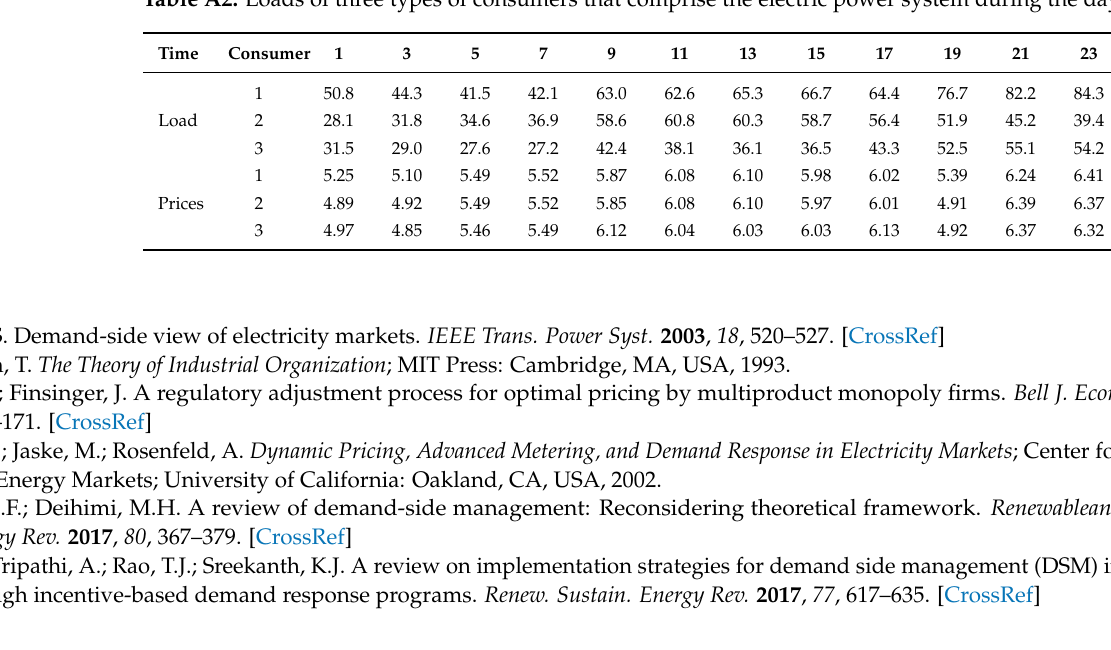
Table A2. Loads of three types of consumers that comprise the electric power system during the